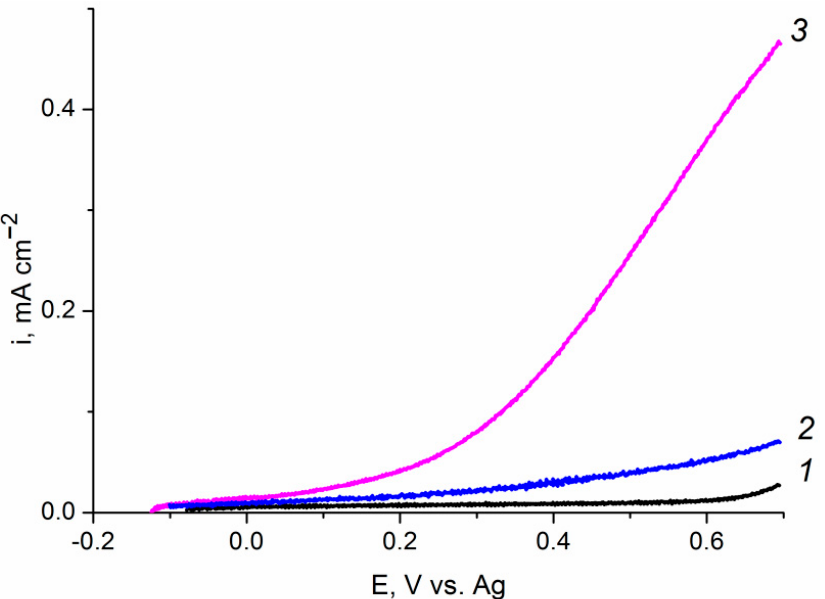
Figure 5. Current-voltage characteristics of (1, 3) Ti 4+ /Fe 2 O 3 /FTO and (2) Fe 2 O 3 /FTO film photoanodes in aqueous solutions of 0.1 M KOH obtained in: (1) dark conditions; (2, 3) under visible light illumination with a power density of 100 mW cm − 2 .